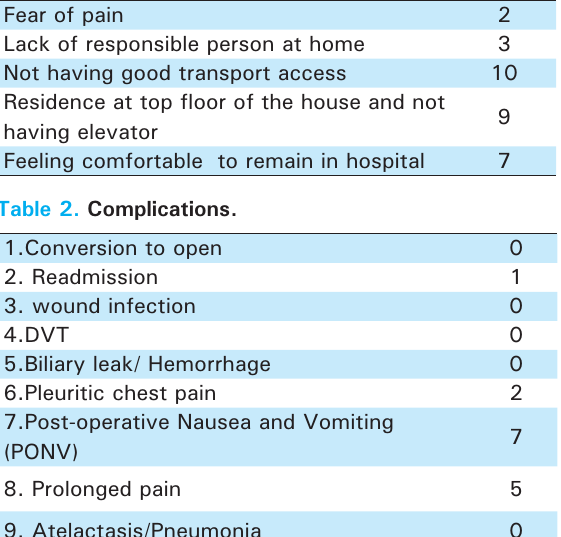
Figure 1. Sex ratio.